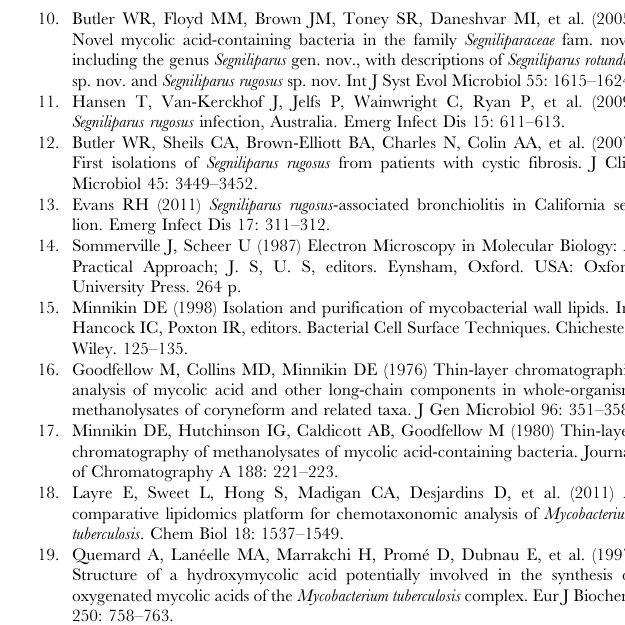
Figure 5. 1H NMR analysis and structural summary of segnilomycolates. (A) 1D TLC purified MAMEs were analyzed by 1H NMR. Spectral assignment for the chemical shifts and splitting patterns of mycolates were based on comparison with values reported in the literature. The large peak at 1.56 ppm was attributed to water and the singlet at 3.49 ppm was attributed to methanol in the samples. (B) Structural summary of Segniliparus mycolic acids. The number of carbons between the functional groups on the meromycolate chains were not determined here, but are based on approximate lengths previously reported. Figure S1 Elemental composition of S. rotundus and S. rugosus mycolates derived from ammoniated adducts. MAMEs derived from S. rotundus and S. rugosus were analyzed by positive-ion mode Q-Tof mass spectrometry. The empiric formulas were deduced from the accurate mass of MAME ammonium adducts. The difference between the detected and the calculated m/z is reported as the error. Figure S2 Elemental composition of S. rotundus and S. rugosus mycolates derived from protonated adducts. MAMEs derived from S. rotundus and S. rugosus were analyzed by positive-ion mode Q-Tof mass spectrometry. The empiric formulas were deduced from the accurate mass of MAME proton adducts. The difference between the detected and the calculated m/z is reported as the error. (TIF)